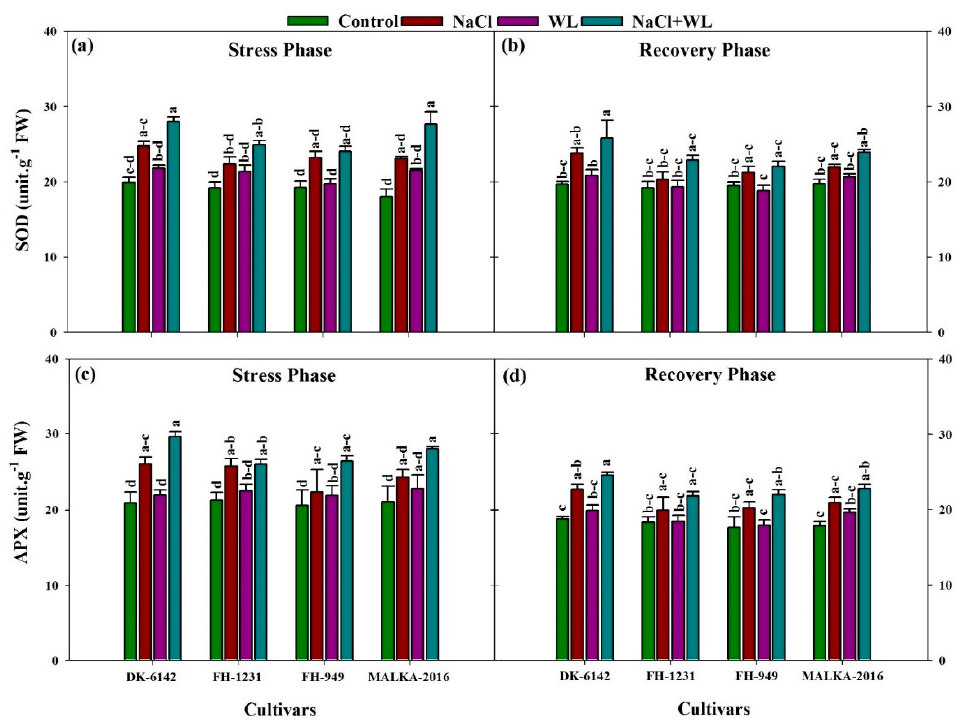
Figure 8. Individual and interactive effects of salinity and waterlogging on superoxide dismutase and ascorbate peroxidase activity in four maize cultivars during the stress (22 DAS) and recovery (30 DAS). Left and right sides of the figure are representing stress phase and recovery phase respectively. Error bars denote the standard error of three replications. Bars with same letter do not differ significantly at p ≤